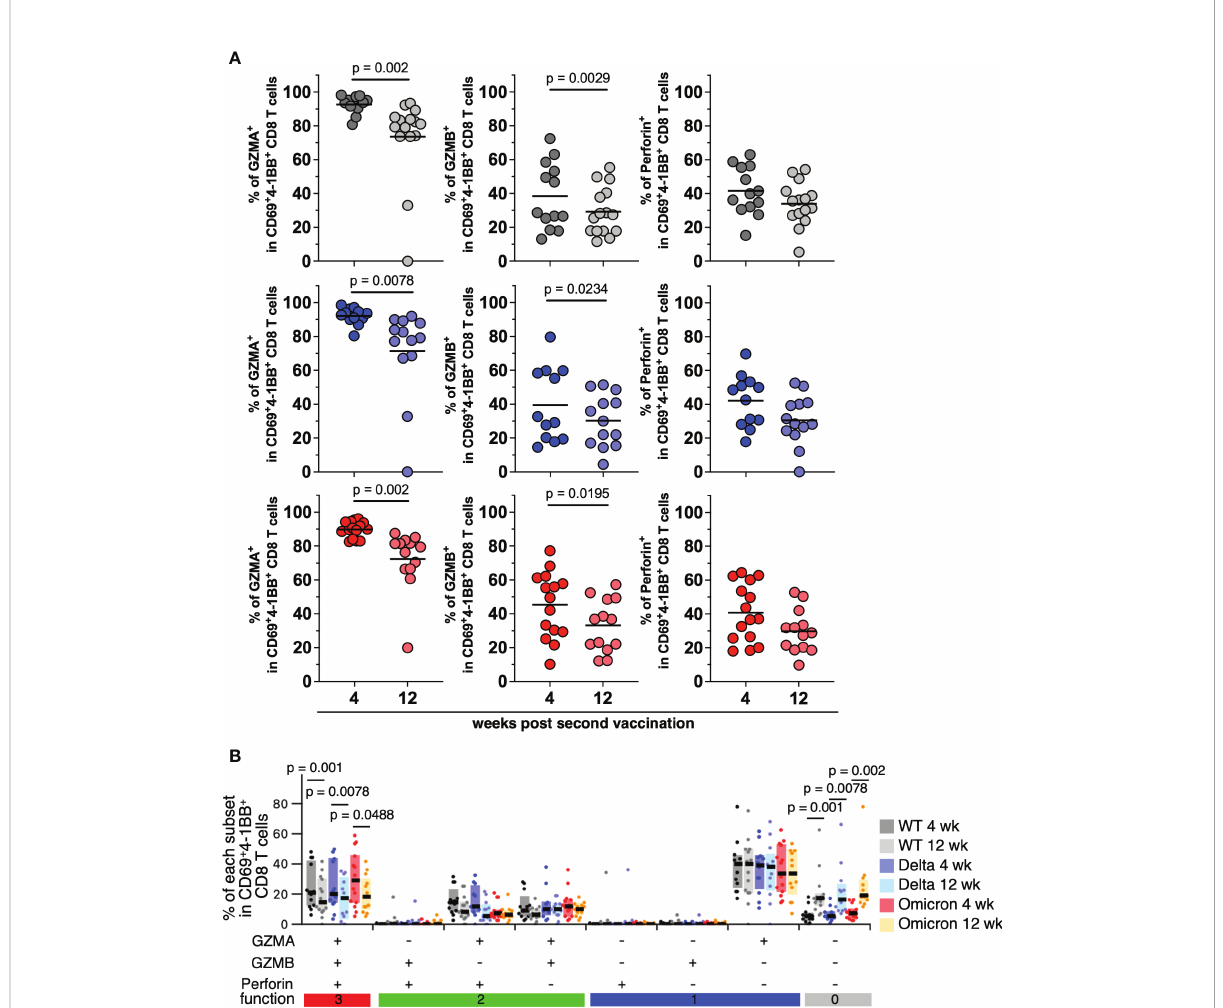
FIGURE 5 CD8 + T cells induced by mRNA vaccine against SARS-CoV-2 variants of concern. (A) Frequencies of CD69 + 4-1BB + CD8 + T cells expressing granzyme A (WT; 80.89% – 98.25%, mean = 92.62% at 4 weeks, 0% – 93.42%, mean = 73.56% at 12 weeks, Delta; 80.32% – 98.5%, mean = 92.17% at 4 weeks, 0% – 91.87%, mean = 71.4% at 12 weeks, Omicron; 82.54% – 96.1%, mean = 89.77% at 4 weeks, 19.91% – 87.48%, mean = 72.34% at 12 weeks; left panels), granzyme B (WT; 13.04% – 72.4%, mean = 38.44% at 4 weeks, 11.63% – 55.25%, mean = 29.19% at 12 weeks, Delta; 14.57% – 79.65%, mean = 39.55% at 4 weeks, 4.44% – 51.41%, mean = 30.21% at 12 weeks, Omicron; 10.2% – 77.16%, mean = 45.3% at 4 weeks, 12.11% – 57.22%, mean = 33.09% at 12 weeks; center panels), or perforin (WT; 15.22% – 63%, mean = 41.51% at 4 weeks, 5.41% – 54.2%, mean = 33.97% at 12 weeks, Delta; 17.84% – 69.76%, mean = 42.08% at 4 weeks, 0% – 52.5%, mean = 30.50% at 12 weeks, Omicron; 18% – 64.4%, mean = 40.77% at 4 weeks, 9.73% – 52.72%, mean = 29.77% at 12 weeks; right panels) responding to SARS-CoV-2 WT, Delta, or Omicron spike peptides (upper, middle, and lower panels, respectively; WT, 4 weeks, n = 13; WT, 12 weeks, n = 15; Delta, 4 weeks, n = 12; Delta, 12 weeks, n = 13; Omicron, 4 weeks, n = 15; Omicron, 12 weeks, n = 13). Lines show the mean. P -values were calculated using the Wilcoxon matched-pairs signed rank test. (B) Frequencies of spike-speci fi c CD69 + 4-1BB + CD8 + T cell subpopulations expressing different combination of granzyme A, granzyme B, and perforin (WT; 6.52% – 48.9%, mean = 23.43% at 4 weeks, 0% – 42.1%, mean = 17.52% at 12 weeks, Delta; 4.17% – 48.8%, mean = 23.5% at 4 weeks, 0% – 35.5%, mean = 16.15% at 12 weeks, Omicron; 6.12% – 59.6%, mean = 30.45% at 4 weeks, 6.32% – 42%, mean = 19.28% at 12 weeks in all positive population). P -values were calculated using the Wilcoxon matched-pairs signed rank test. P -values were calculated using the nonparametric Mann – Whitney U